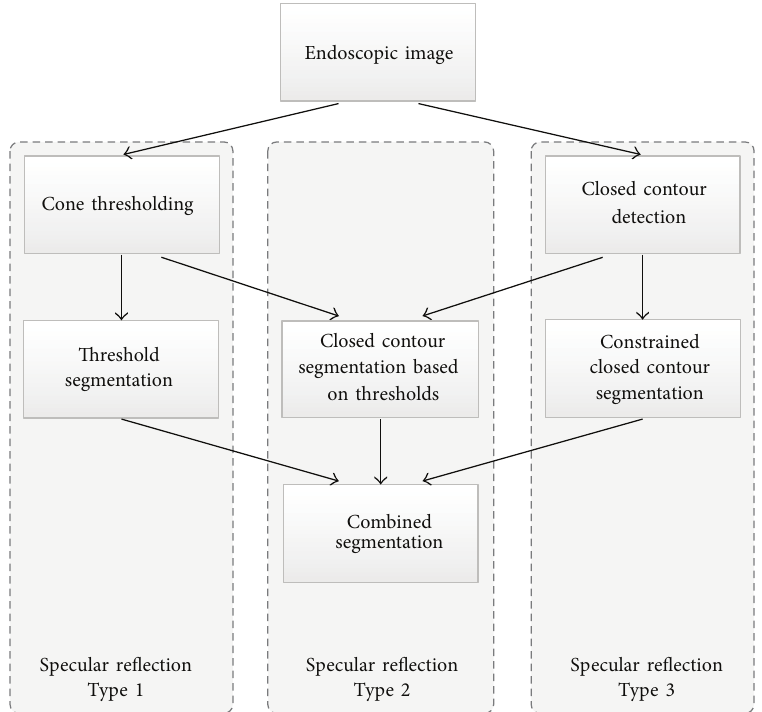
Figure 2: Overview of the hybrid closed contour thresholding algorithm. Three different process lines are used for the detection and are combined in a final segmentation. The contour-based segmentation is capable of segmenting even tiny specular reflections which cannot be detected by a single threshold. Furthermore, the closed contour supports reflections of Type 2, which have been detected by thresholding with a precise boundary. Reflections of Type 1 are large specular reflections with a smooth gradient and a bright central part.